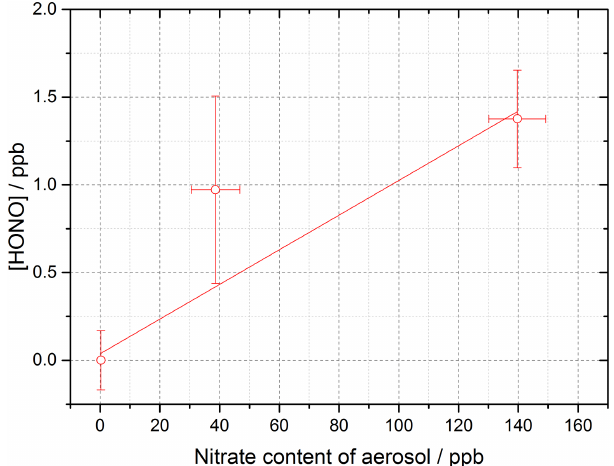
Figure 11. Dependence of the HONO concentration generated as a function of aerosol surface area density for pure NH 4 NO 3 aerosol (black open squares, error bars represent 1 σ ) and 1 : 1 TiO 2 / NH 4 NO 3 mixed aerosol (red open circles, error bars rep- resent 1 σ ). Both experiments were performed in N 2 at 295K, an illuminated residence time of 30s and a lamp photon flux of (8.29 ± 2.39) × 10 16 photonscm − 2 s − 1 . The NH 4 NO 3 -only exper- iment was performed at ∼ 50 ± 5% RH, while the TiO 2 / NH 4 NO 3 mix experiment was performed at 20 ± 2% RH. For all points, the background HONO observed without illumination has been sub- tracted. At zero aerosol surface area density there is no HONO gen- erated from the walls of the flow tube.